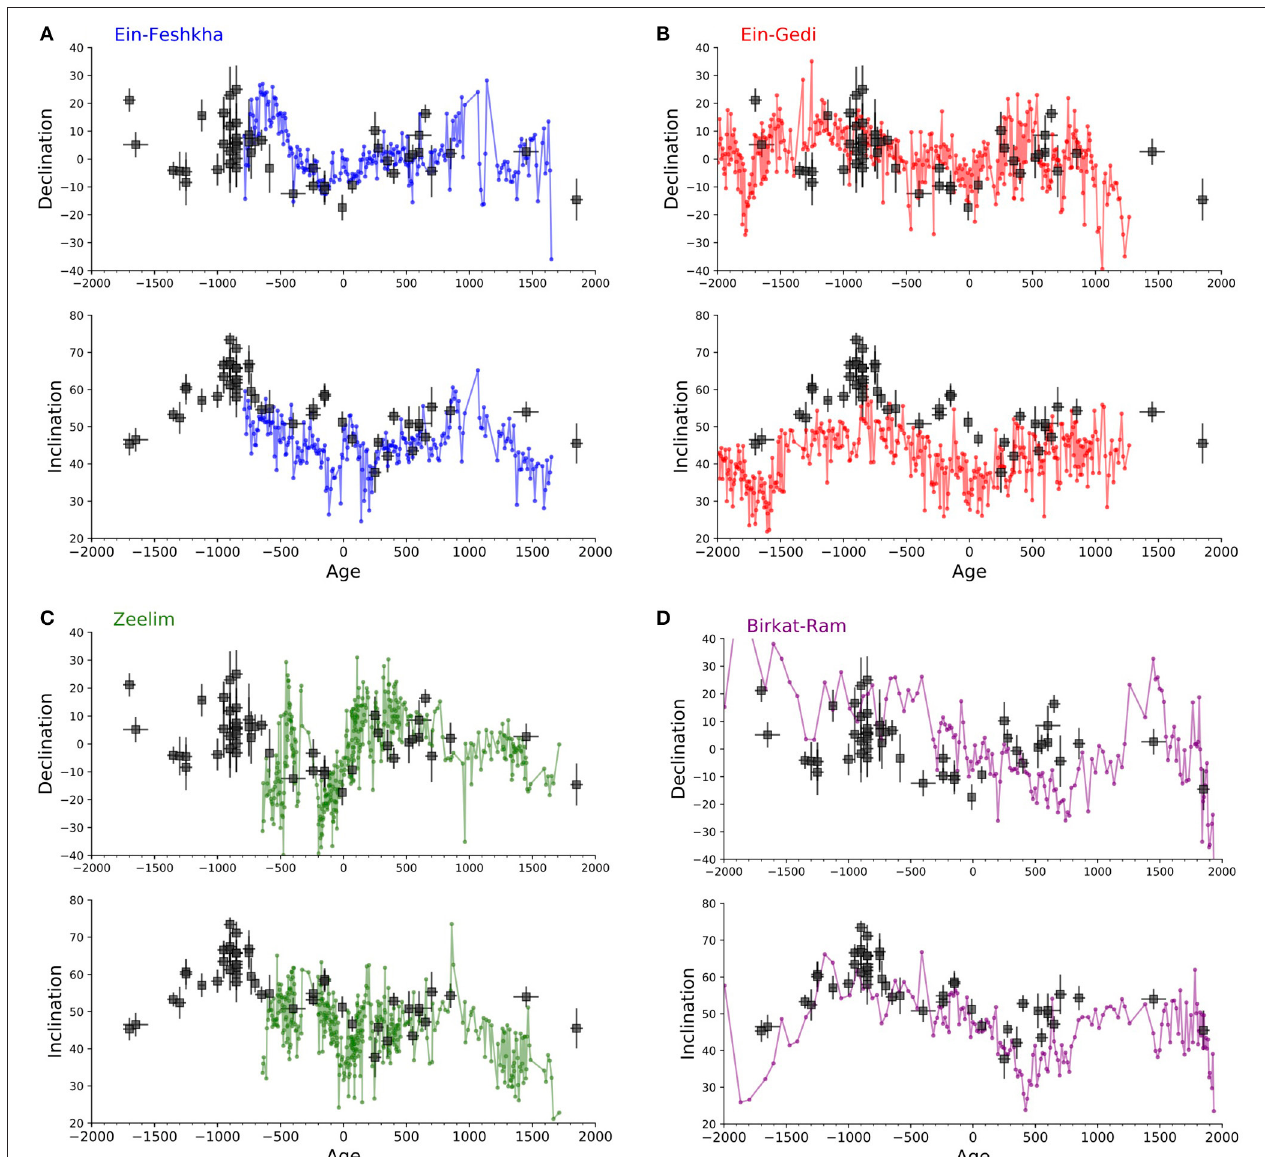
FIGURE 4 | Comparison between sedimentary paleomagnetic data (colored symbols) and archaeomagnetic data from this study (black symbols). (A,C) Dead Sea cores data from Ein-Feshkha (A) , Ein-Gedi (B) , and Zeelim (C) ; (D) Birket Ram Maar lake. Sedimentary data were downloaded from the GEOMAGIA50 database (Brown et al., 2015) following Frank et al. (2002,